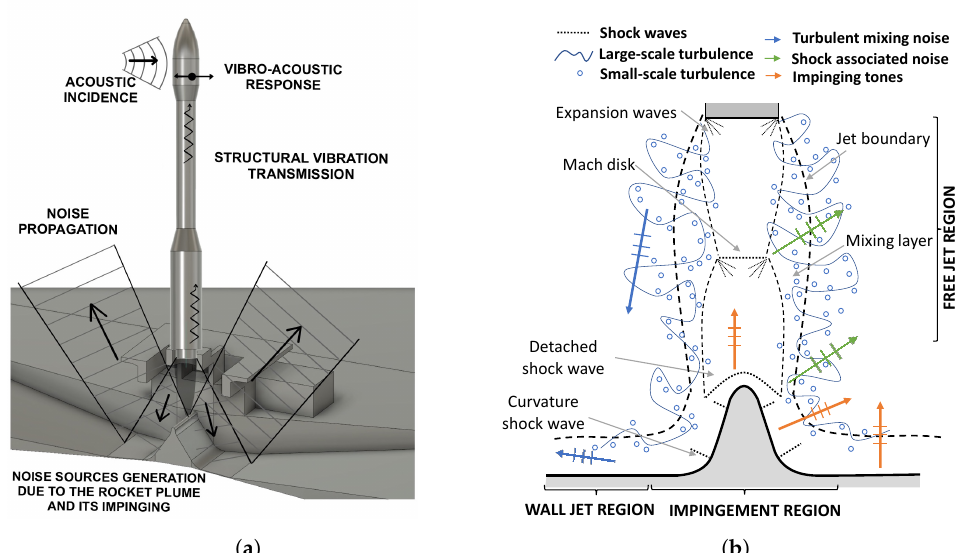
Figure 1. Sound generation and transmission during a rocket launch. ( a ) Scheme of noise transmission paths. ( b ) Scheme of noise sources due to the rocket